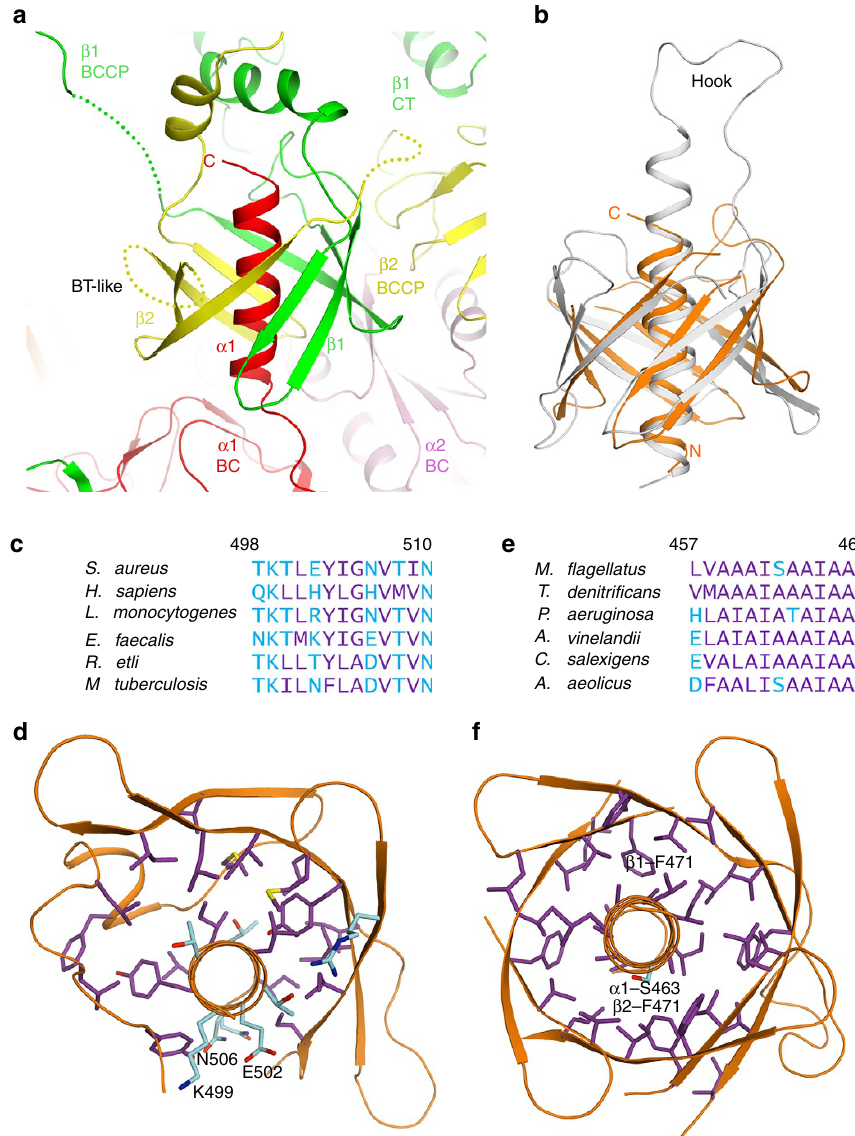
Figure 3 | A BT-like domain in the structure of two-subunit PC. ( a ) Schematic drawing of the BT-like domain in MfPC. The helix comes from the a subunit (red), and the two four-stranded b -sheets come from two separate b subunits (green and yellow). Each subunit is given a different colour to highlight the origins of the protein segments in the BT-like domain. ( b ) Overlay of the structures of the BT-like domain of MfPC (orange) and the BT domain of PCC (grey) 20 . ( c ) Sequence alignment of the residues in the a helix of the PT domain in single-chain PCs. Hydrophobic residues are coloured purple, and hydrophilic ones in cyan. ( d ) The a helix of the PTdomain in SaPC is amphipathic, with half of its surface having hydrophilic residues and exposed to the solvent. Hydrophobic side chains are coloured in purple, and hydrophilic ones in cyan. ( e ) Sequence alignment of the residues in the a helix of the BT-like domain in two-subunit PCs, at the C-terminal end of the a subunit. ( f ) The a helix of the BT-like domain in MfPC is hydrophobic, completely surrounded by the b -barrel and having mostly small side